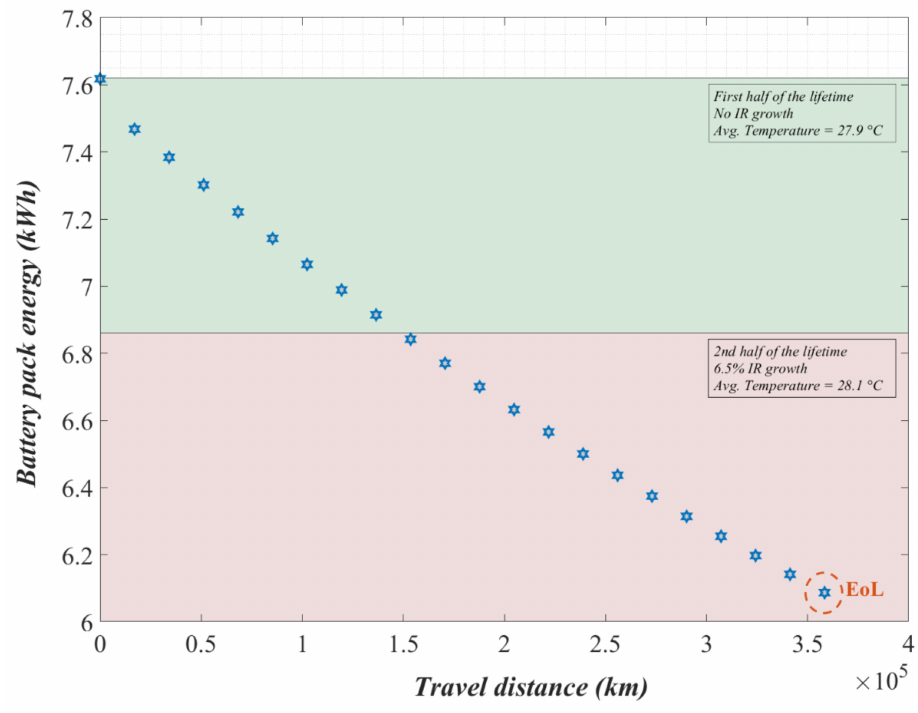
Figure 8. Pack-level lifetime simulation with parameter